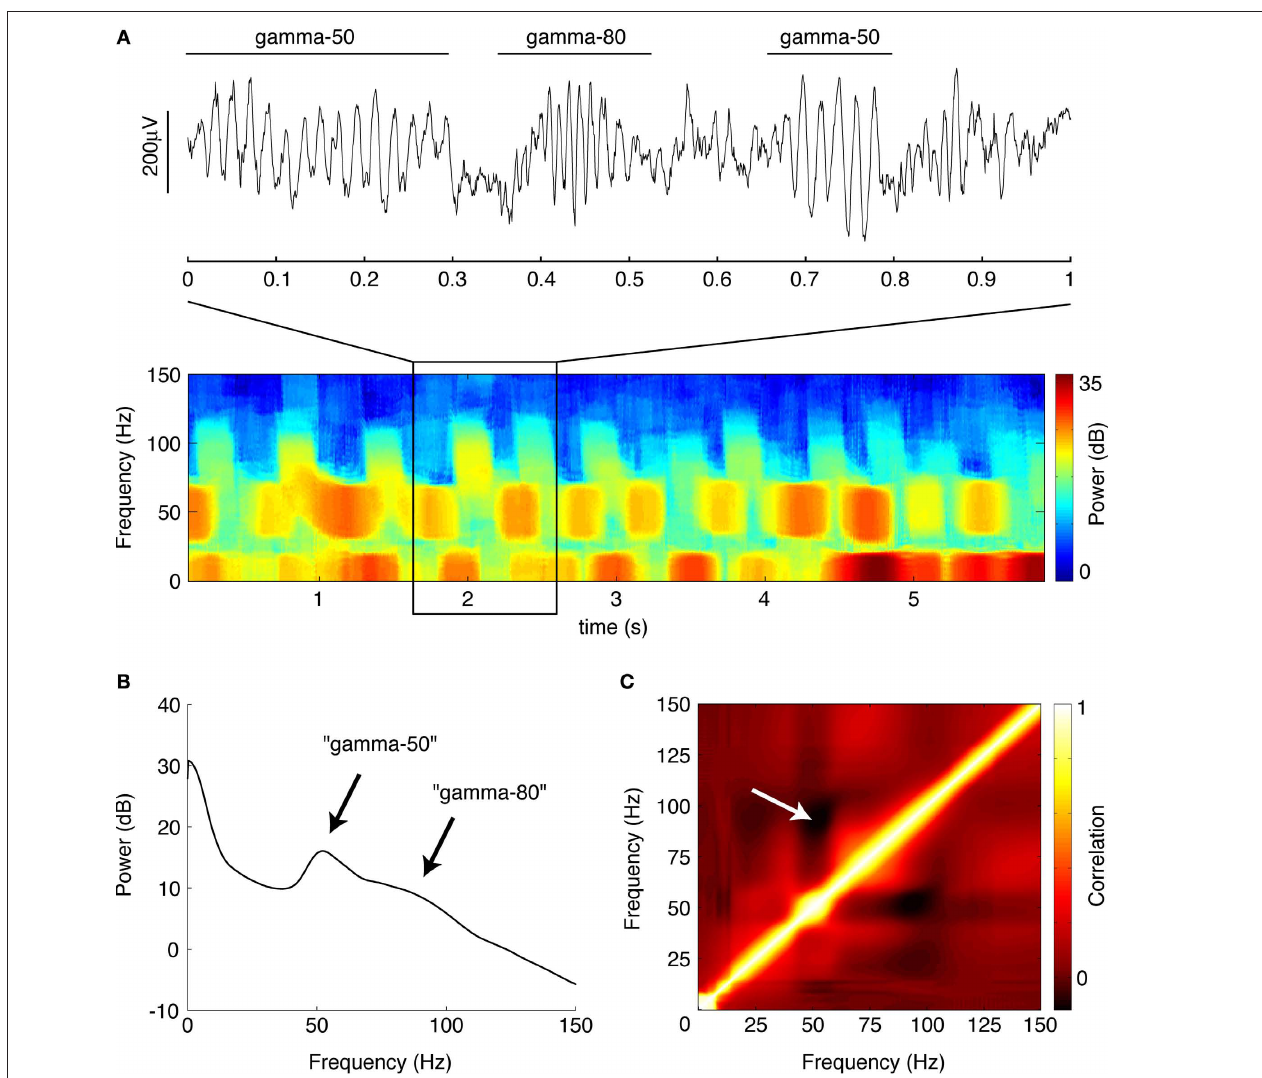
FIGURE 4 | Ventral striatal local fi eld potentials contain low and high gamma frequencies. (A) Example unfi ltered local fi eld potential trace containing alternating gamma-50 and gamma-80 power (top) and associated spectrogram (bottom) with characteristic structure. For display only, the spectrogram was obtained using a 250-ms time window at 10-ms time step resolution. Units on the spectrogram are in dB, a log-transform of power (µV 2 )/Hz). Taken from session R117-2007-06-01, tetrode 7. (10 × log 10